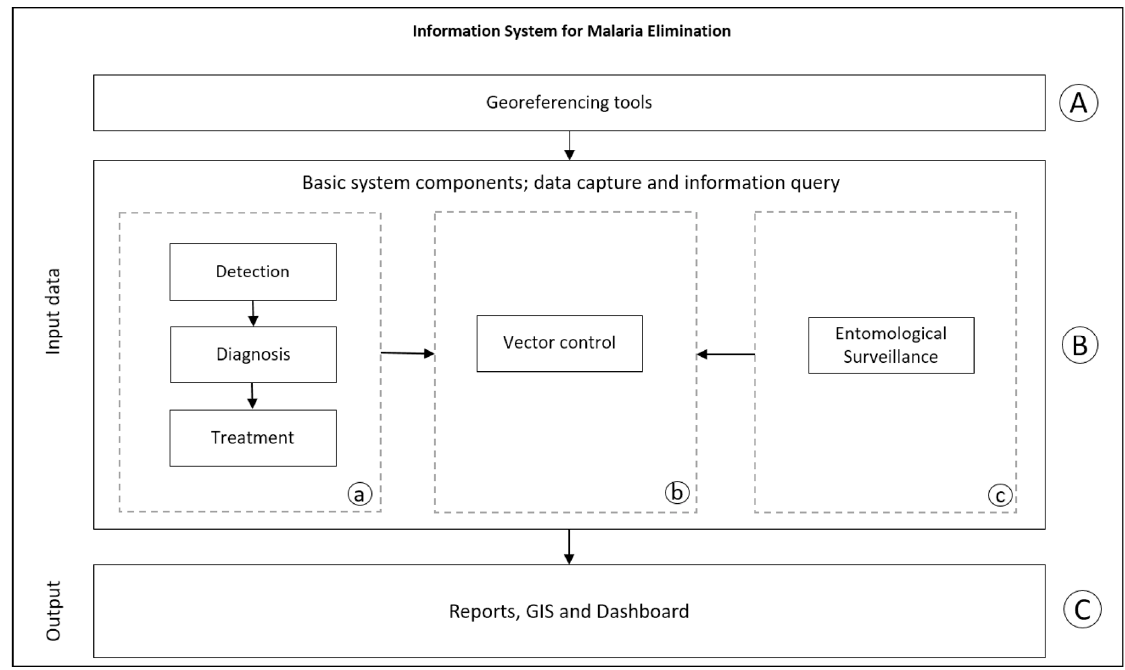
Figure 3. GISTEM modules and data flow. (A–C) Are the modules of system; (a–c) Are the componets of system.